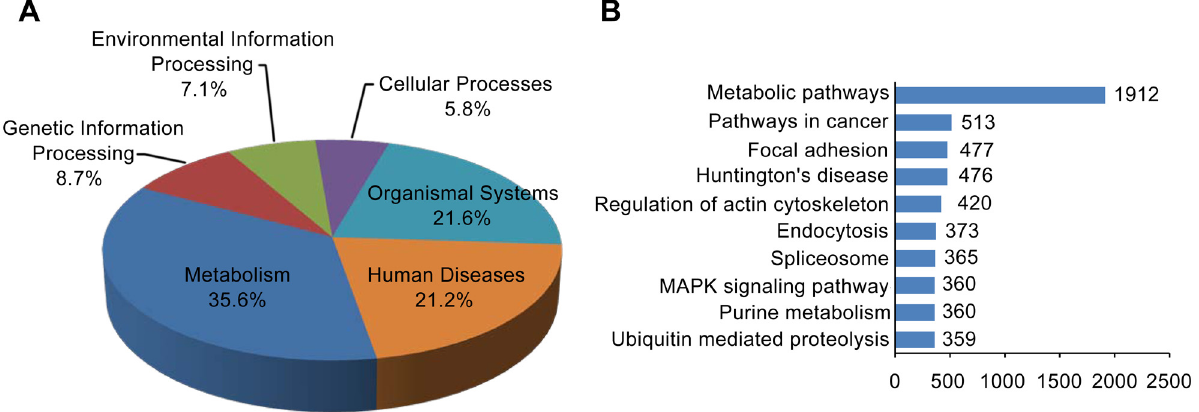
Fig 2. Categorization of unigenes into KEGG biochemical pathways. A total of 13,663 unigenes were assigned to 241 KEGG pathways belonging to six categories. (A) The percentage of the pathway amount in each category is shown. (B) The ten largest groups with KEGG database annotation. The x-axis indicates the number of annotated